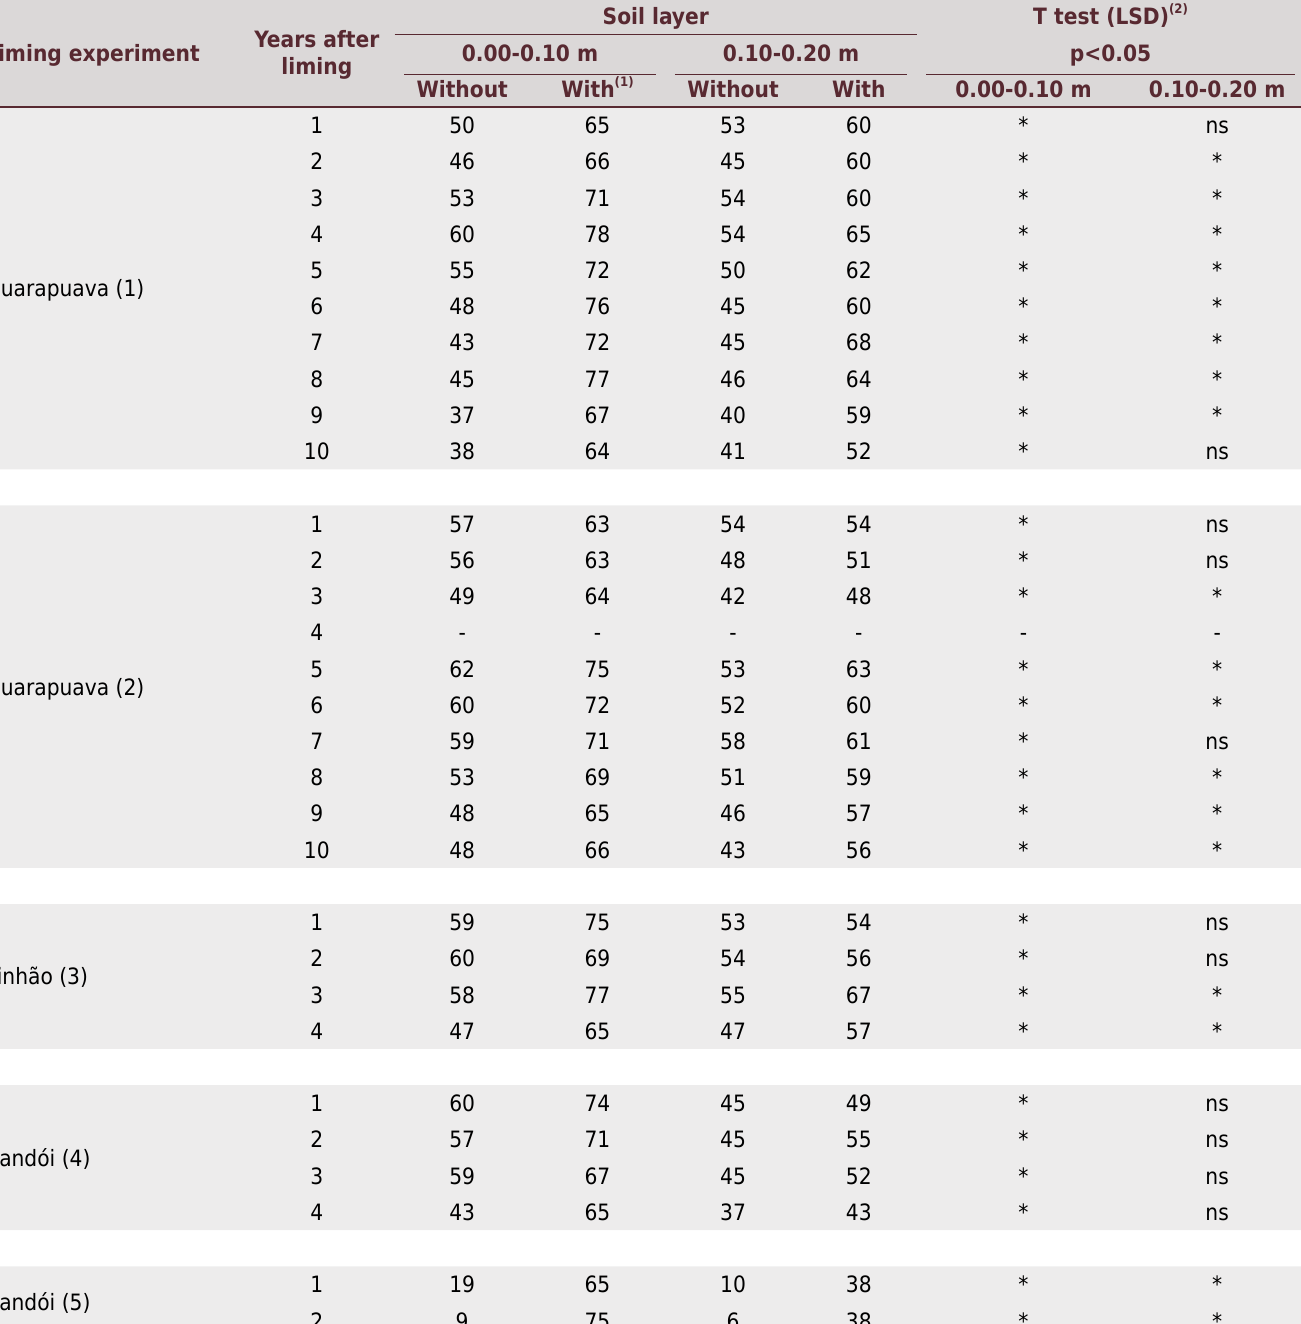
Table 2. Base saturation in two layers from one to 10 years after surface liming in no-till Humic Hapludox soils from the South-Central region of Paraná